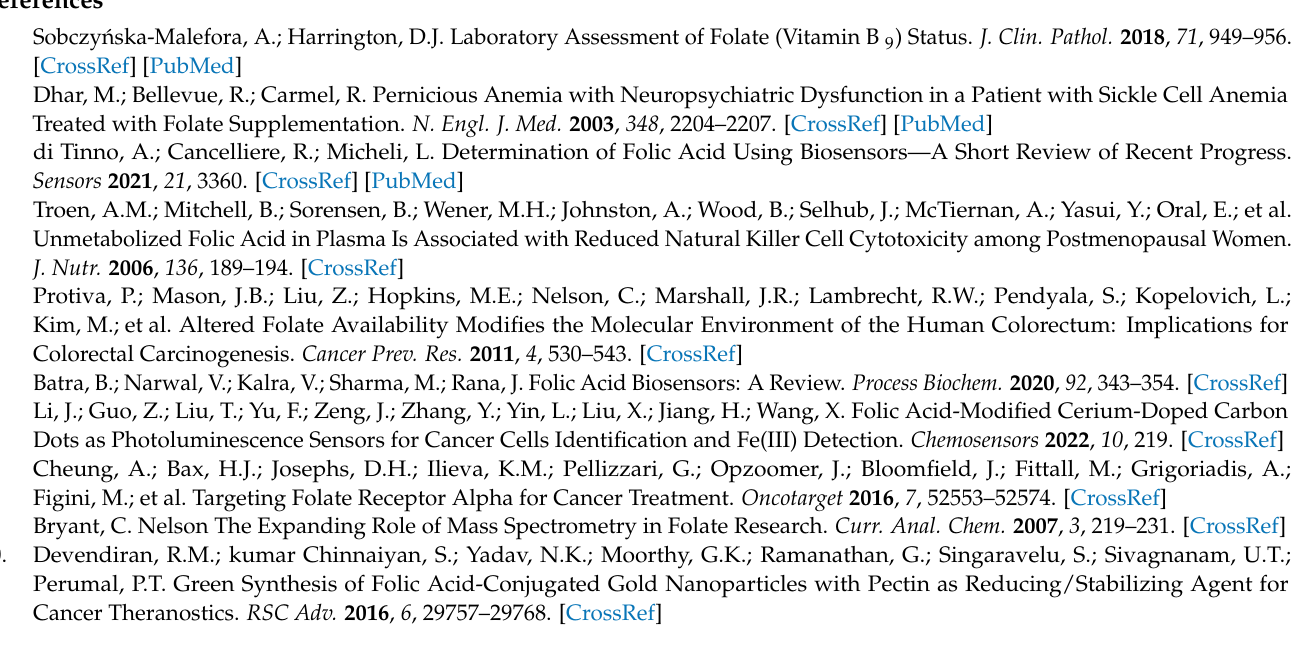
with the sensor chip surface that was not pre-activated by cardiimide; Figure S7: Studies on selectivity of the developed chemosensor in the presence of non-target